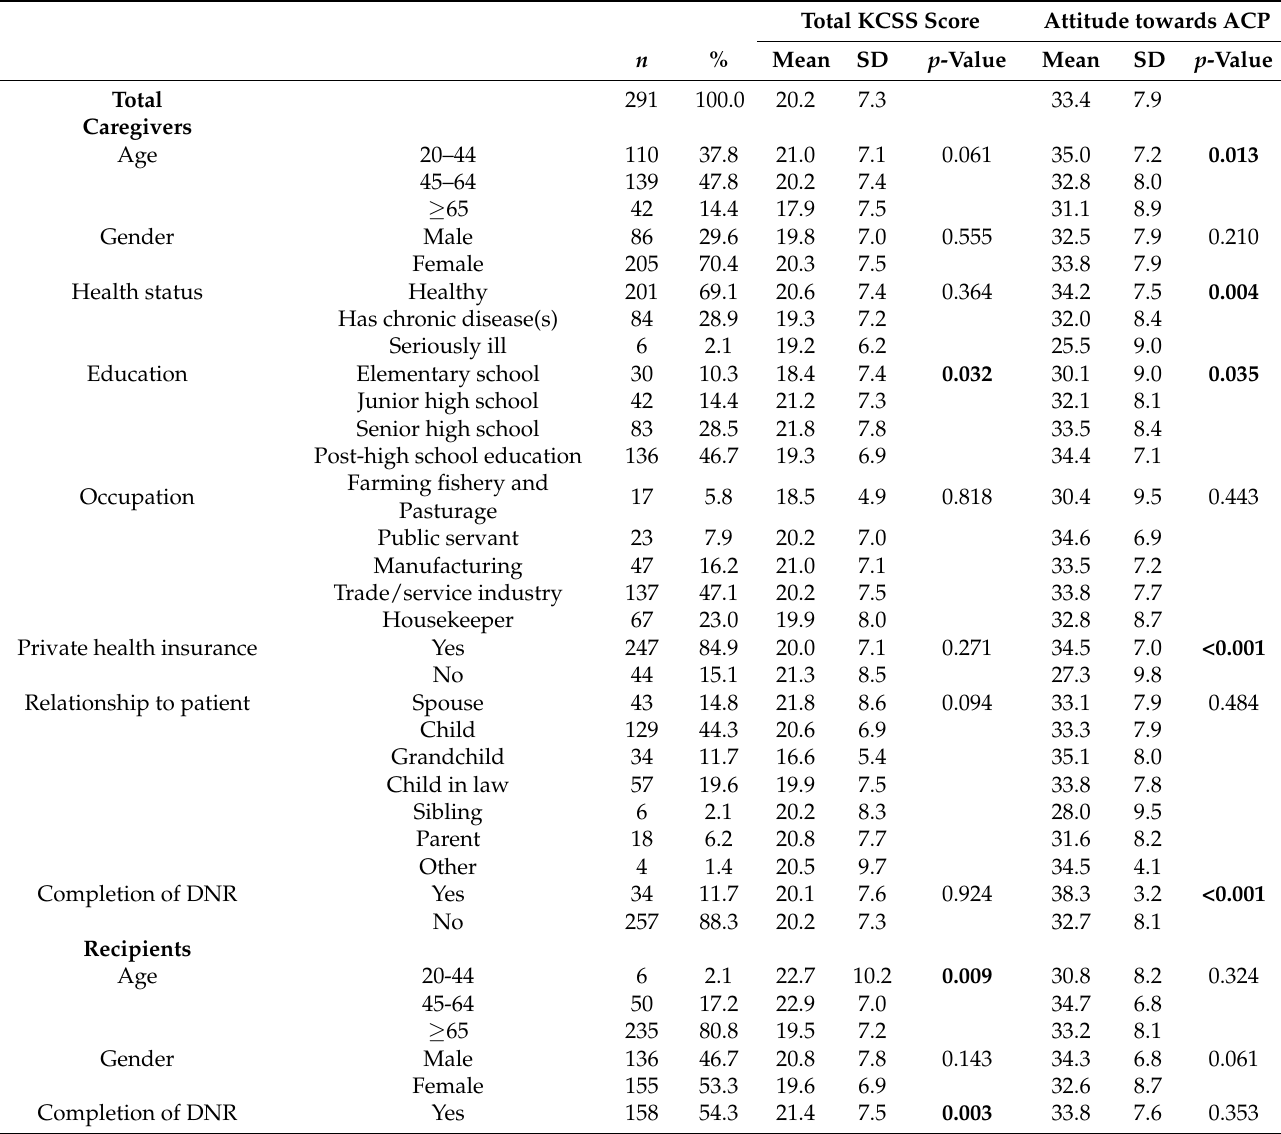
Table 1. The relationship between the demographics of family caregivers/recipients and KCSS and